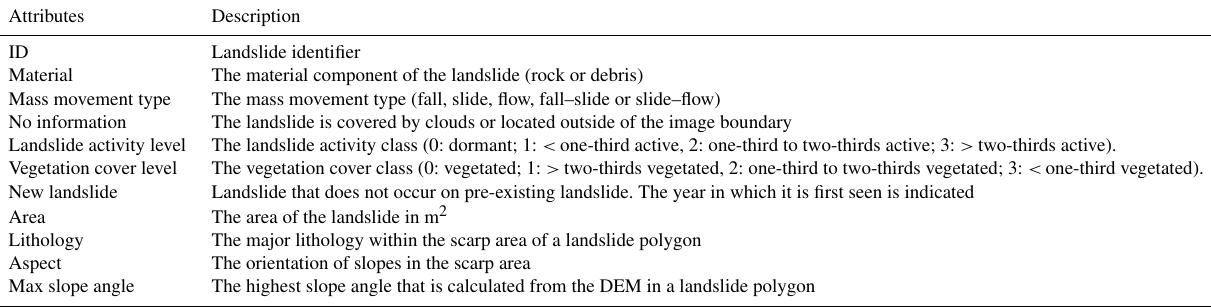
Table 2. Attributes collected for the landslide